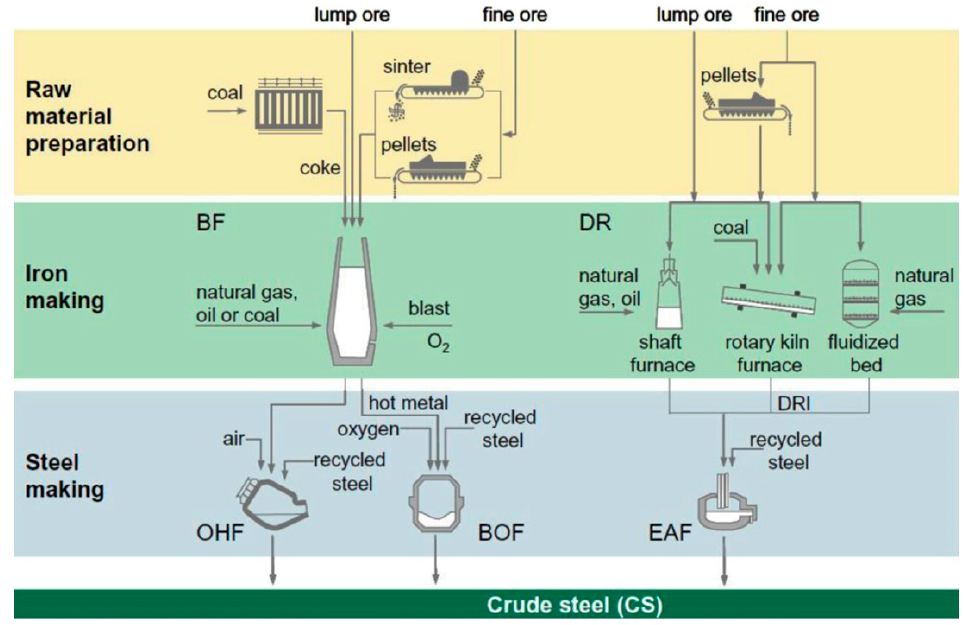
Figure 1. Schematic diagram of ore based steel-making routes (adopted with permission from [23]).